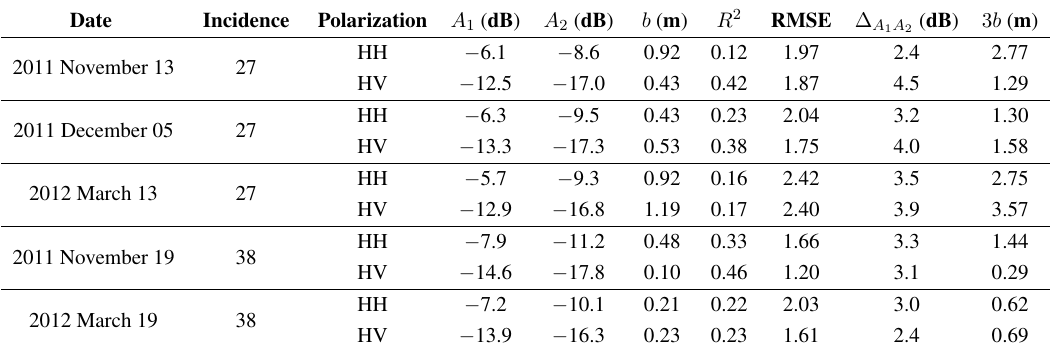
Table 4. Results for regression analysis of TerraSAR-X backscattering coefficients as a function of shrub mean